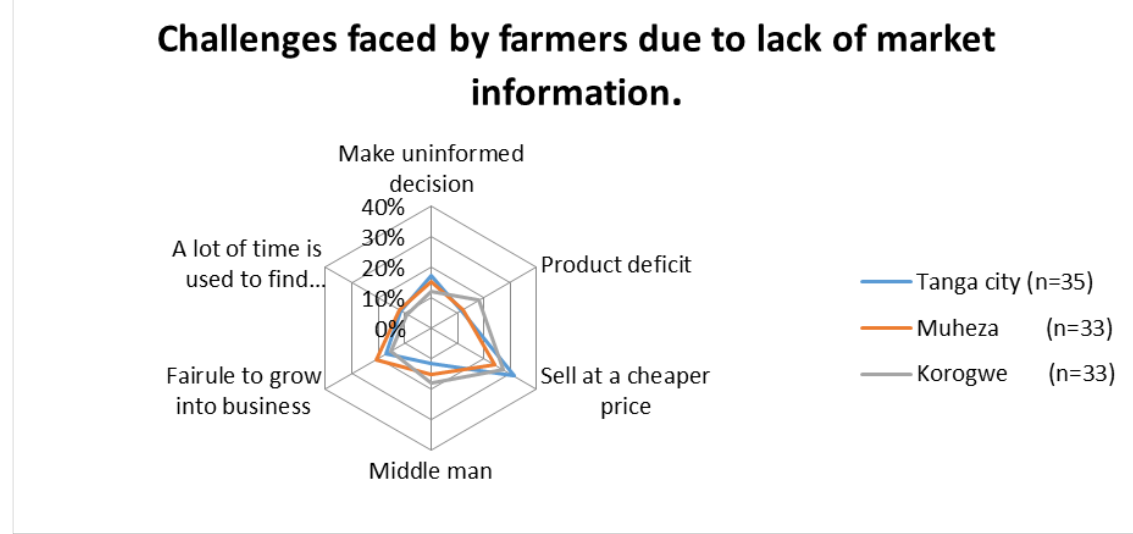
Figure 5. Description of challenges faced by poultry farmers due to lack of market information,